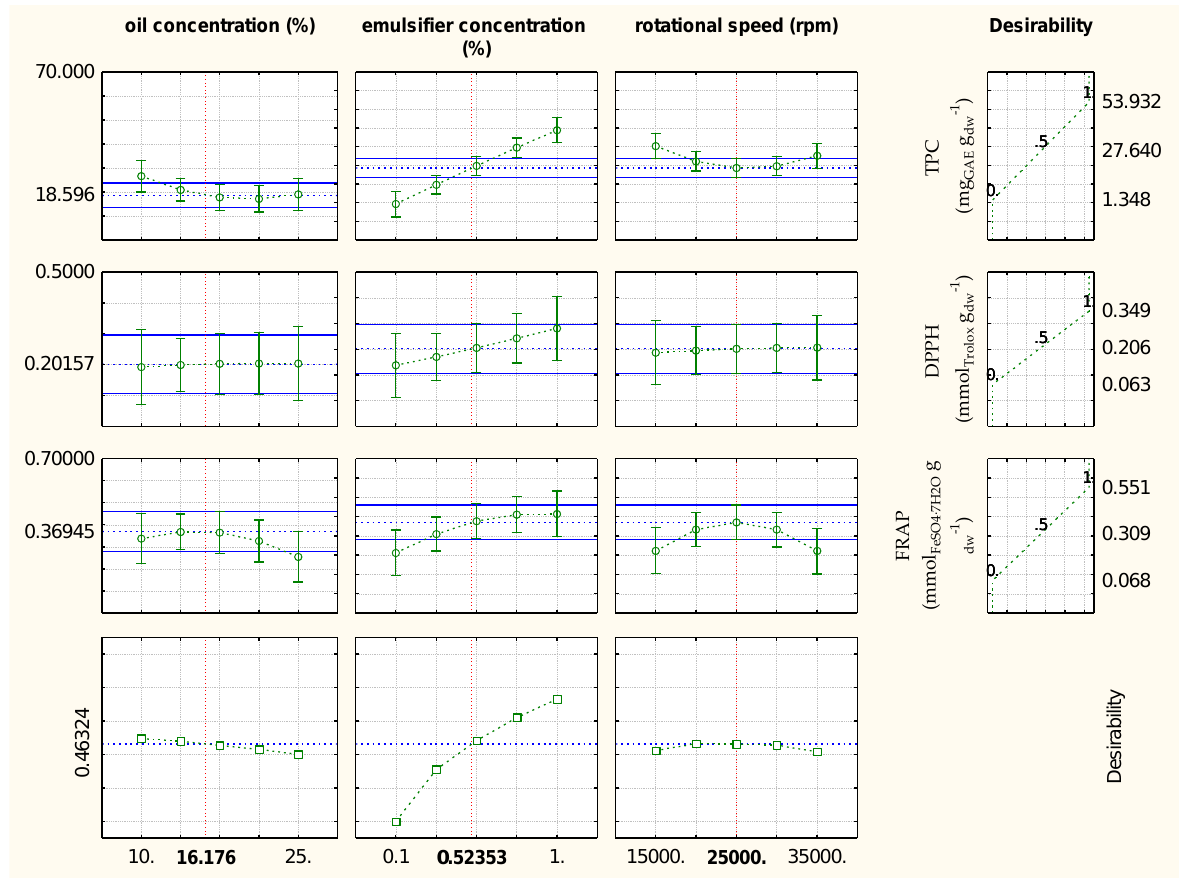
Figure 5. Results of the optimization of the emulsification conditions with regard to chemical properties (TPC, DPPH, FRAP) for oil-in-water emulsions containing rosemary extract. The optimal process conditions for the emulsified oregano extracts were as follows (Figure 6): oil concentration = 16.25%, emulsifier concentration = 0.52%, and rotational speed = 25,000 rpm with values of TPC = 57.55 mg GAE g dw − 1 , DPPH = 0.31 mmol Trolox g dw − 1 , and FRAP = 0.58 mmol FeSO4 · 7H2O g dw − 1 . The optimal experimental values for TPC and